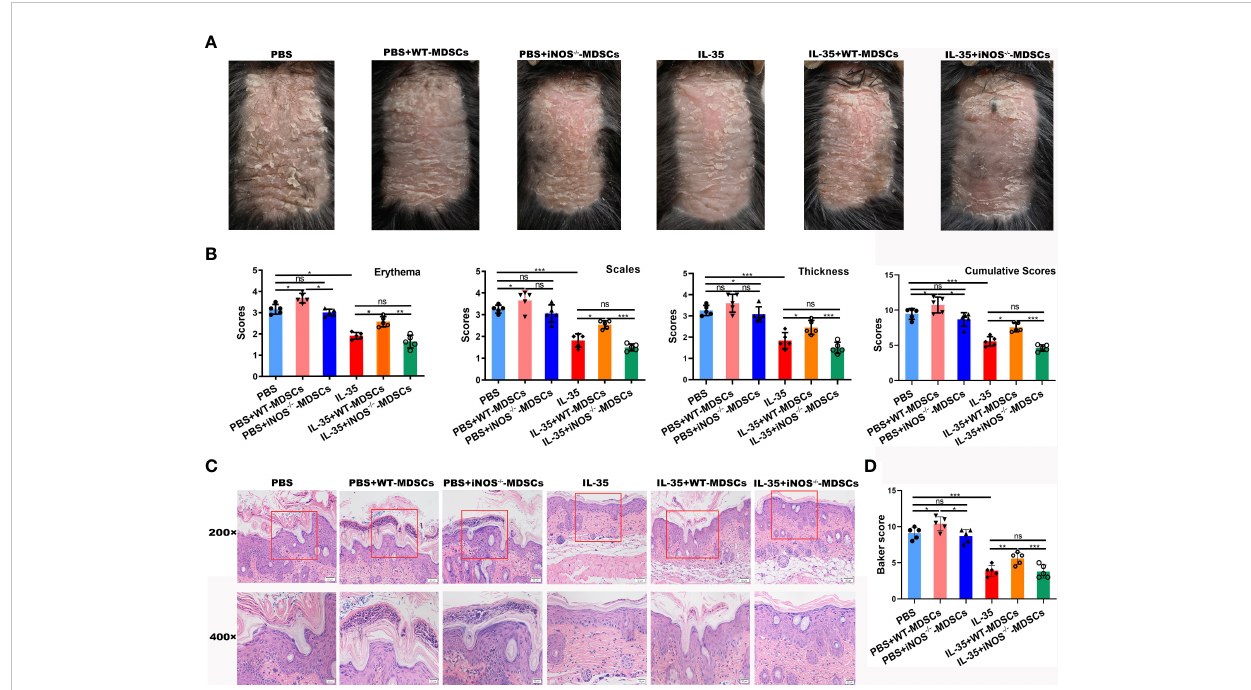
FIGURE 9 Adoptive transfer of iNOS -/- MDSCs had no effect on the function of IL-35 in mice with IMQ-induced psoriasis. (A) Representative phenotype of murine skin after adoptive transfer of WT-MDSCs and iNOS -/- MDSCs. (B) PASI scoring of erythema, scaling, and thickness, and the cumulative scores for different groups. (C) H & E-stained skin sections (200× and 400× magni fi cation; the 400× image is the enlarged image in the box). (D) Pathological scores of skin sections (N = 5) using the Baker scoring system. Data are presented as means ± standard deviation. *P < 0.05, **P < 0.01, ***P < 0.001. H & E, hematoxylin and eosin; IL, interleukin; IMQ, imiquimod; iNOS, inducible nitric oxide synthase; MDSC, myeloid-derived suppressor cell; ns, not signi fi cant; PASI, Psoriasis Area and Severity Index; WT,